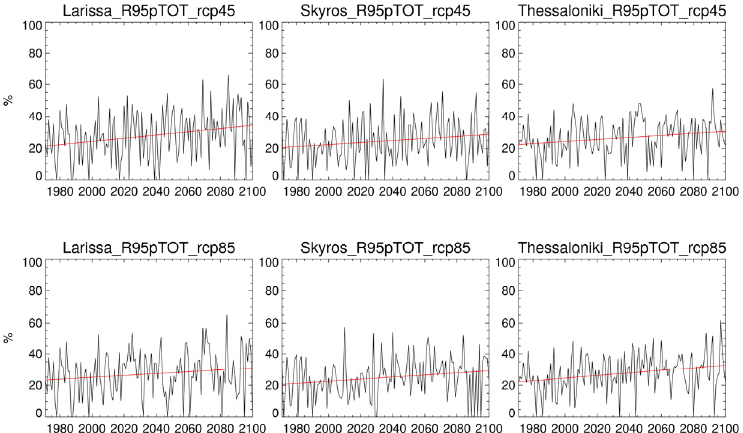
Figure 12. Fraction of the total wet-day rainfall from very wet days (R95pTOT) during 1971–2100 in four Greek stations based on RCP8.5.